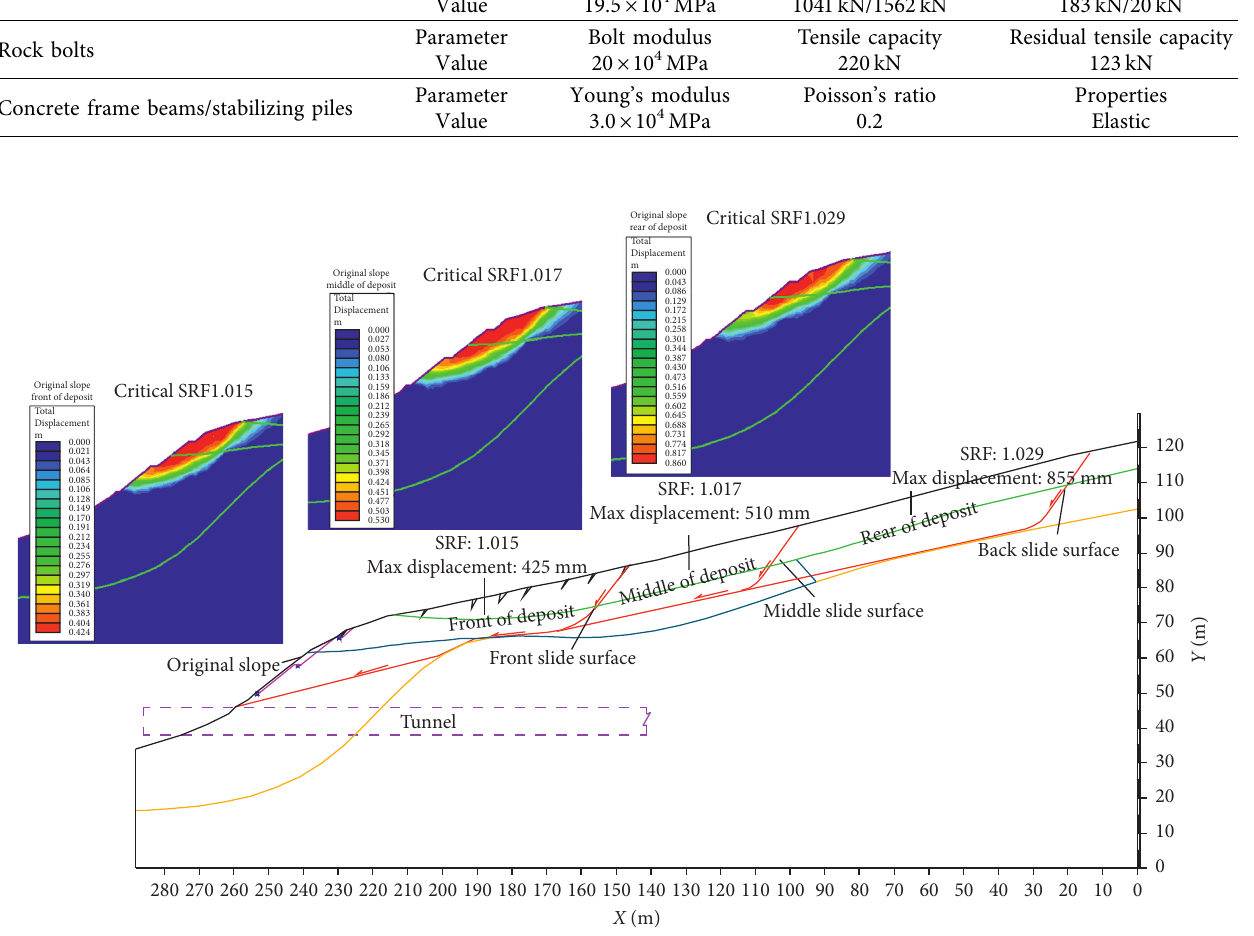
Figure 4: SSR analysis results for 1-1 profile section of natural deposit